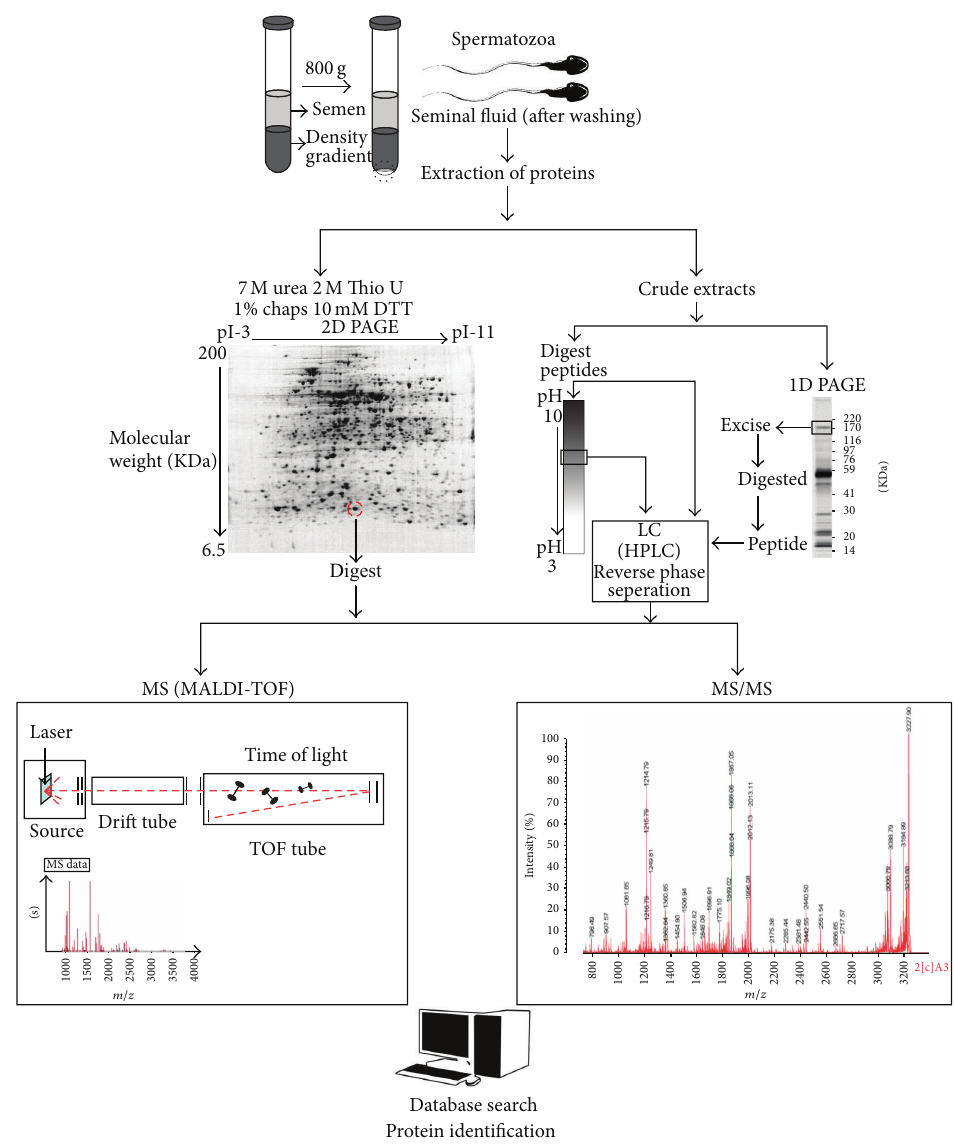
Figure 2: Schematic diagram showing the extraction and analysis of proteins from sperm cells. After collection and liquefaction of a whole semen sample, it can be used as it is or it can be subjected to density gradient centrifugation to separate mature and immature sperm populations. The recovered spermatozoa can be extracted and purified, after which the protein concentration can be determined in order to allow for an equal protein-loading gradient on electrophoretic gels. The further analysis of the sperm proteome is done from an aliquot of the spermcellsbyusingtwo-dimensionalpolyacrylamidegelelectrophoresis(2D-PAGE)followedbyexcisionofproteinspotsfromthe2D-PAGE gels and matrix-assisted laser desorption/ionization-mass spectroscopy (MALDI-MS) or tandem MS (MS/MS) identification. Alternatively, the initial protein extract can be digested into peptides, which can be separated via liquid chromatography, followed by MS/MS